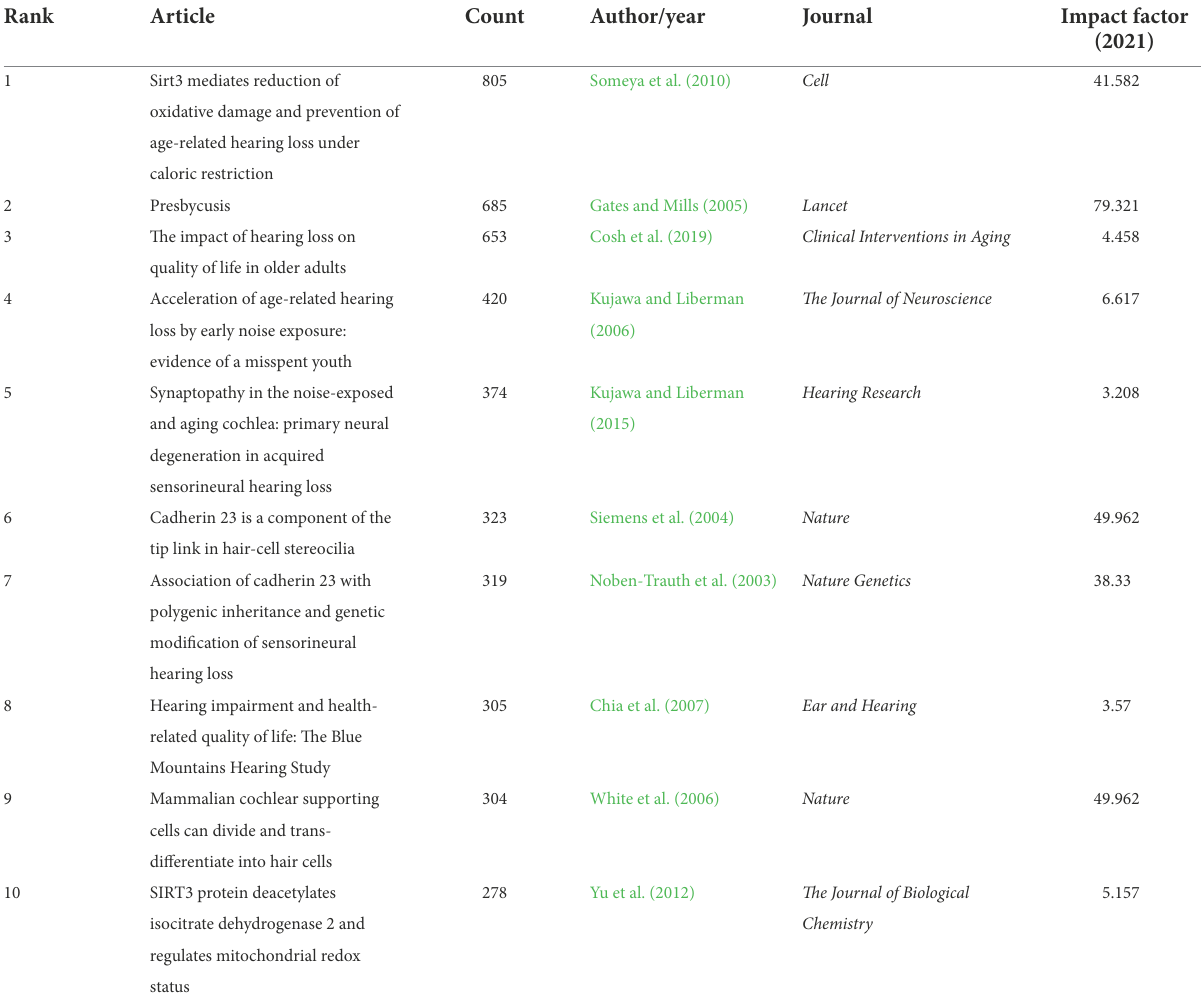
TABLE 1 Top 10 references on aged-related hearing